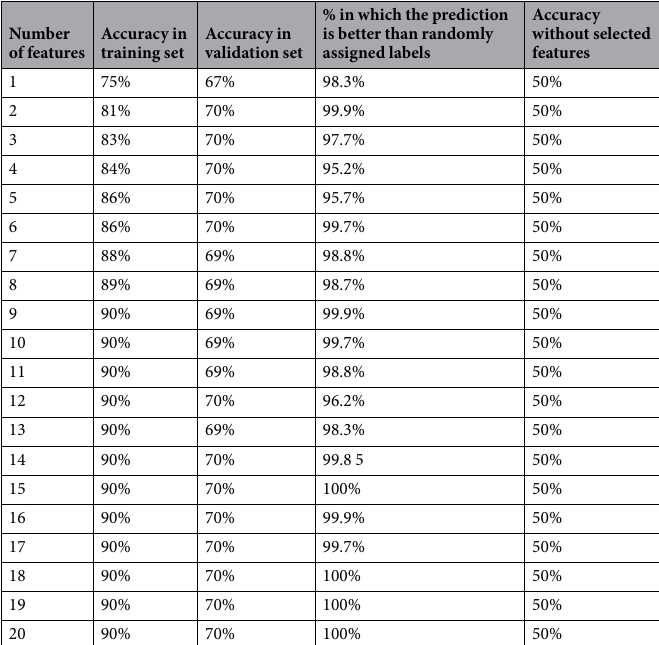
Table 4. Summary of the extracted features for second analysis with training and validation sets for time frequency data showing feature number, accuracy in training set, accuracy in validation set, corresponding p-value for permutation test and accuracy without selected features. All accuracy values are